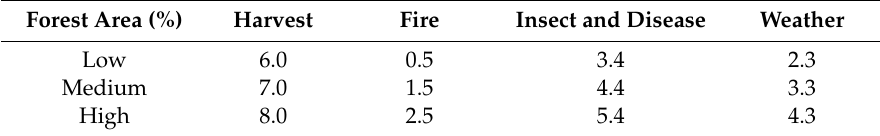
Table 4. Average annual disturbance rates with low (L), medium (M), and high (H) severity in the study region.